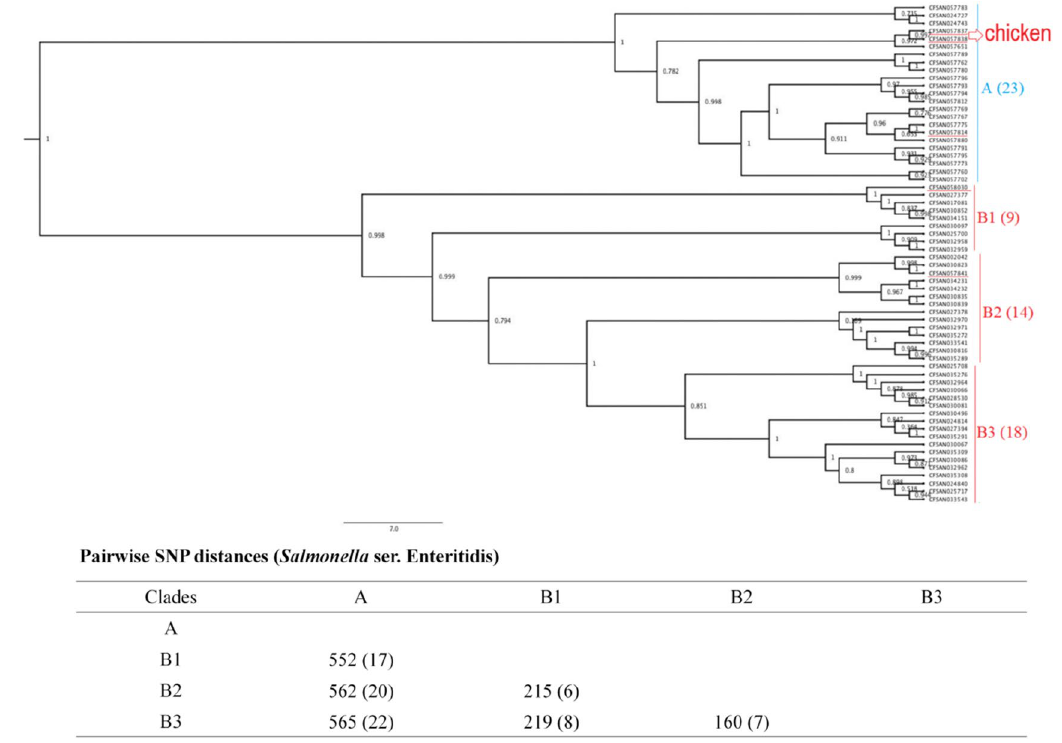
Figure 1. Phylogenetic tree of 64 Salmonella ser. Enteritidis isolates. Using core SNPs determined by FDA CFSAN SNP pipeline, the tree was constructed using the GTR-CAI model of FASTree 2. The analysis involved 552–565 total SNP positions. Clades and subclades are indicated in colors ( A , blue; and B , red) with numbers of total isolates in each clade or subclade in parentheses. Isolates sourced from chicken samples were highlighted under red line, the rest were from egg